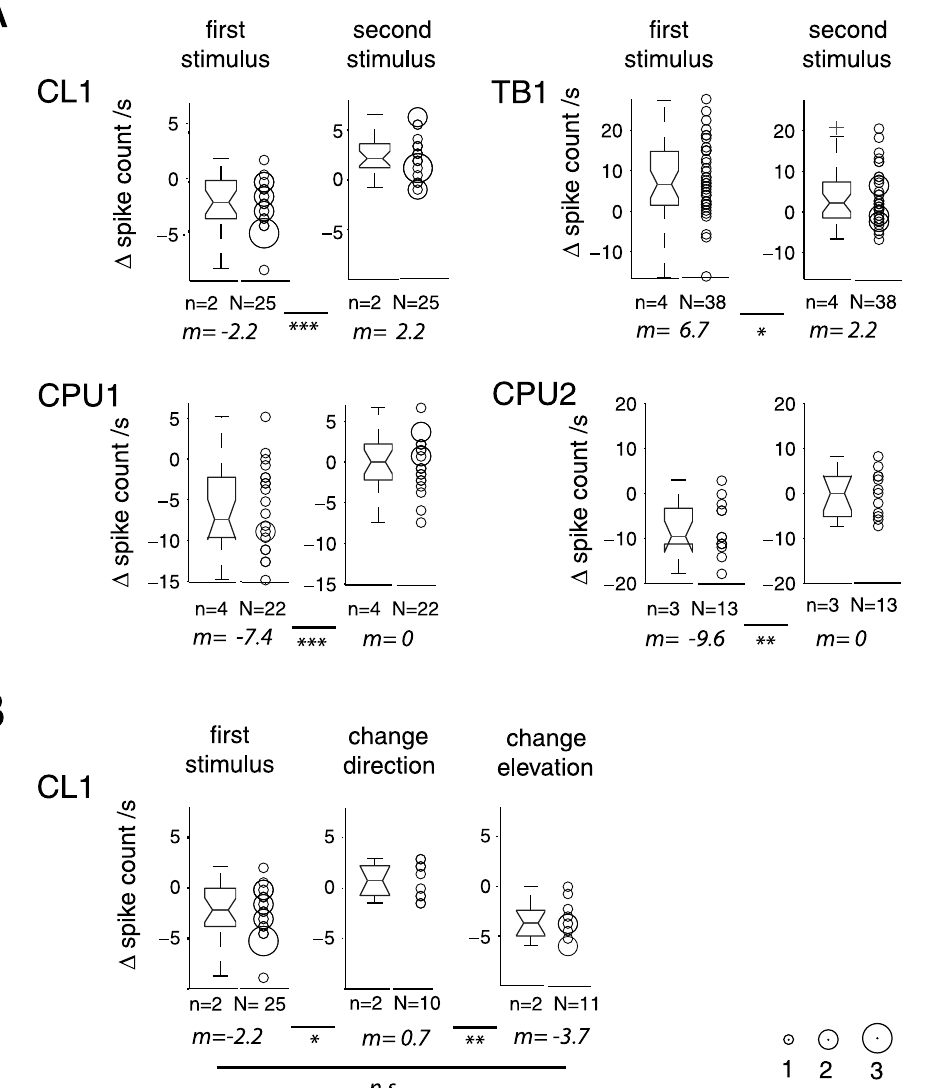
Fig 4. Stimulus-specific adaptation of responses to small-field motion in CL-, TB- and CPU neurons. A. Responses to small-field motion are marked by rapid adaptation between the first and second presentation of a single moving small-field square. Box- and bubble plots show differences in spike count between stimulus time-windows and background activity in a period of 450 ms preceding stimulation, based on N responses obtained from n neurons. Notches in box plots indicate 95% confidence interval of the median and circular plot markers in bubble plots are scaled to the frequency of observations (see scale, bottom right). Some outliers were truncated for the sake of better visualization. m , median; asterisks: level of statistical significance (Bonferroni- corrected) of difference in median as calculated by Wilcoxon rank-sum tests ( * p corr < 0.05, ** p corr < 0.01, *** p corr < 0.001). TB1 cells showed excitatory responses to the first stimulus in a sequence, while all other types of neuron showed inhibition. Note the increased spike rate of CL1 cells during presentation of the second stimulus, which is related to rebound-spiking after the inhibitory response to the first stimulus (see Fig 3D). Data include many cases where first and second stimulus differed in direction of motion (see Table 1). Nevertheless, pronounced adaptation occurs between the first and second stimulus. B. In many cases, adaptation could be reversed by switching the elevation of a horizontal trajectory, as illustrated here for population data of CL1 neurons sufficient in sample size for statistical